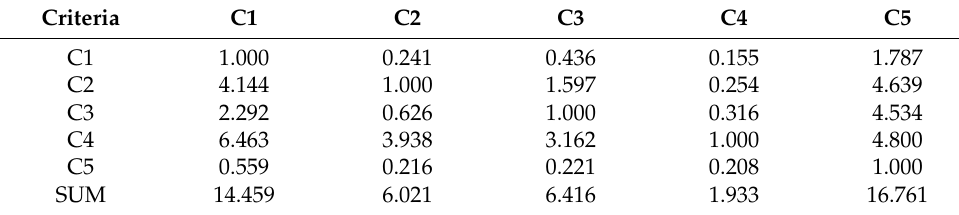
Table 3. Crisp matrix for the CR.